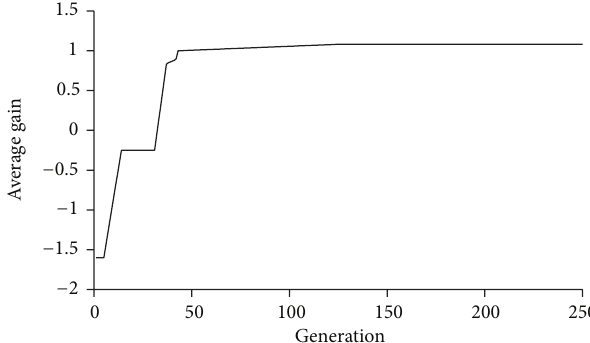
Figure 15: Average directivity (gain) increment after 246 genera- tions (taken from Matlab).